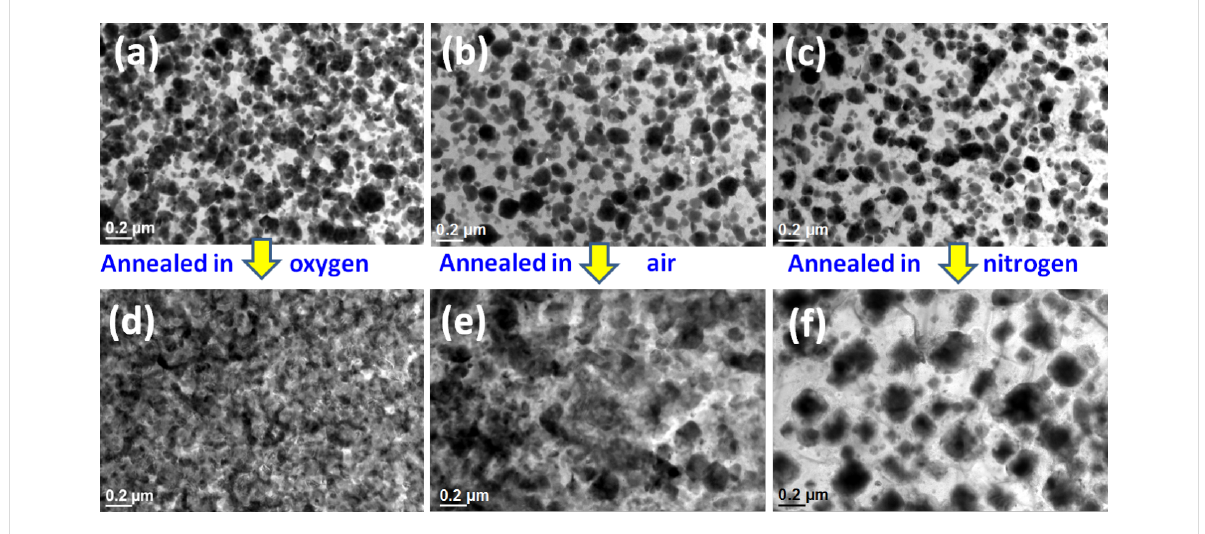
Figure 6: (a–c) Cu nanoparticles on Si substrates deposited via the galvanic displacement reaction, and (d–f) when the same substrates were annealed in oxygen, air, nitrogen, respectively.